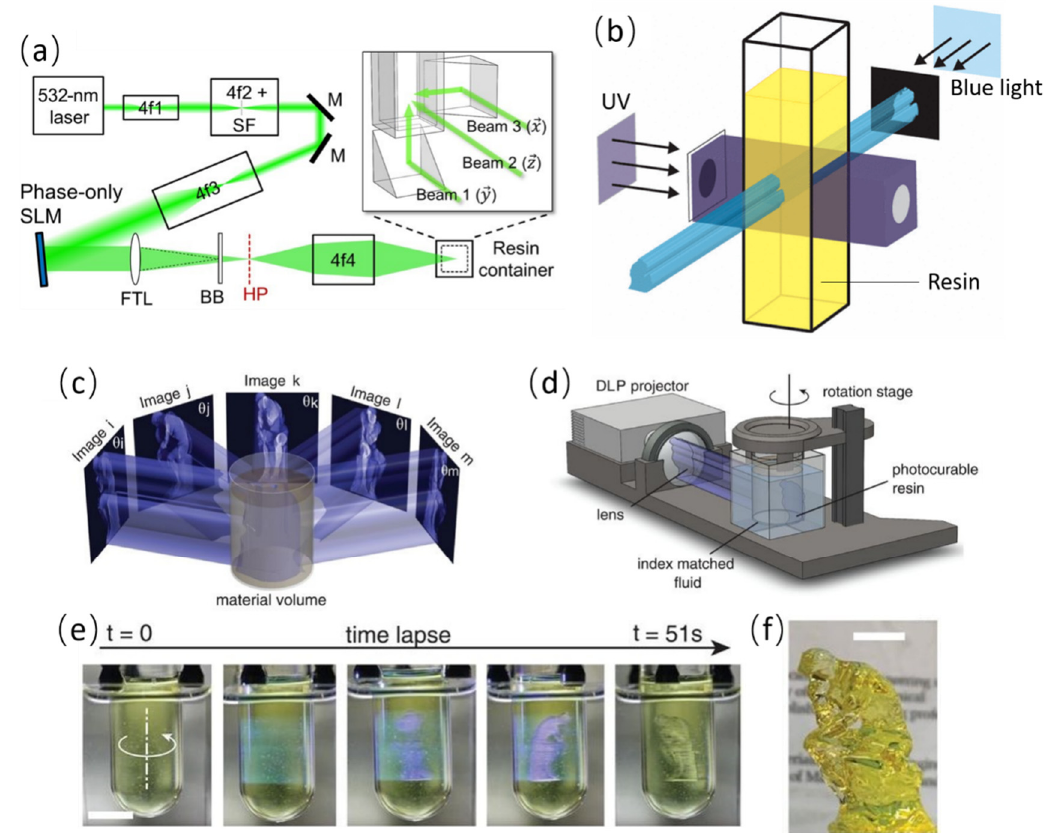
Figure 7. Volumetric stereolithography. ( a ) SLM, liquid crystal on silicon spatial light modulator; FTL, Fourier transform lens; BB, beam block to eliminate undiffracted light; HP, hologram plane; 4fN, telescope lens pairs in the “4-f” configuration used for beam expansion or image relaying; 4f2 incorporates a pinhole spatial filter (SF). The inset image details the configuration of 45° prism mirrors for directing image subcomponent beams at orthogonal directions into the resin volume [20]. ( b ) Schematic diagram of dual-wavelength volumetric polymerization. The polymerization process is inhibited by UV light and initiated by blue light [101]. ( c ) The concept of tomographic volumetric stereolithography: Patterned illumination from many directions delivers a computed 3D exposure dose to a photoresponsive material. ( d ) The tomographic volumetric stereolithography system. ( e , f ) show the printing process and a model printed by tomographic volumetric stereolithography. Scar bar: 10 mm [21].